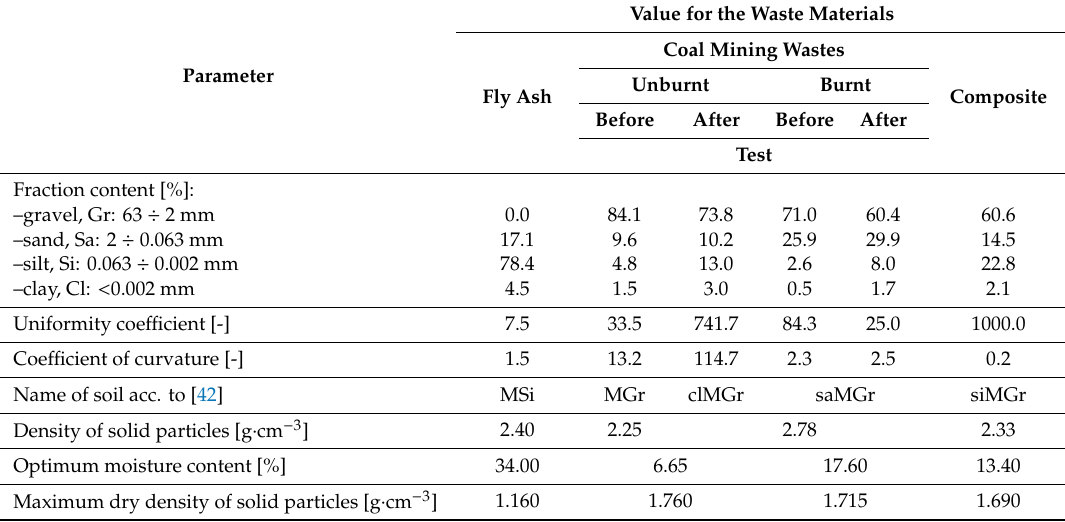
Table 1. Geotechnical characteristics of tested waste